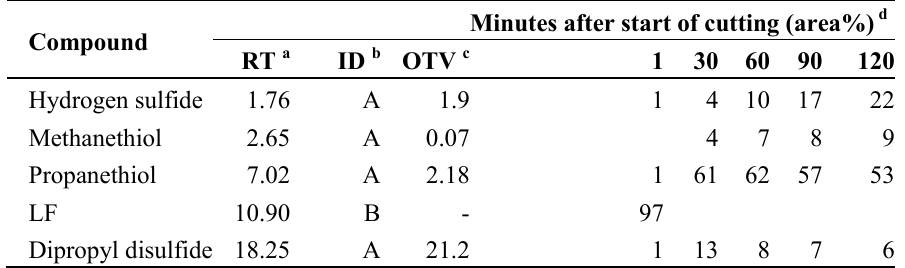
Table 2. Volatile compounds found in headspace from freshly cut onions by GC-SCD. Minutes after start of cutting (area%) d Compound RT a ID b OTV c 1 30 60 90 120 Hydrogen sulfide 1.76 A 1.9 1 4 10 17 22 Methanethiol 2.65 A 0.07 4 7 8 9 Propanethiol 7.02 A 2.18 61 62 57 53 LF 10.90 B - 97 Dipropyl disulfide 18.25 A 21.2 1 13 8 7